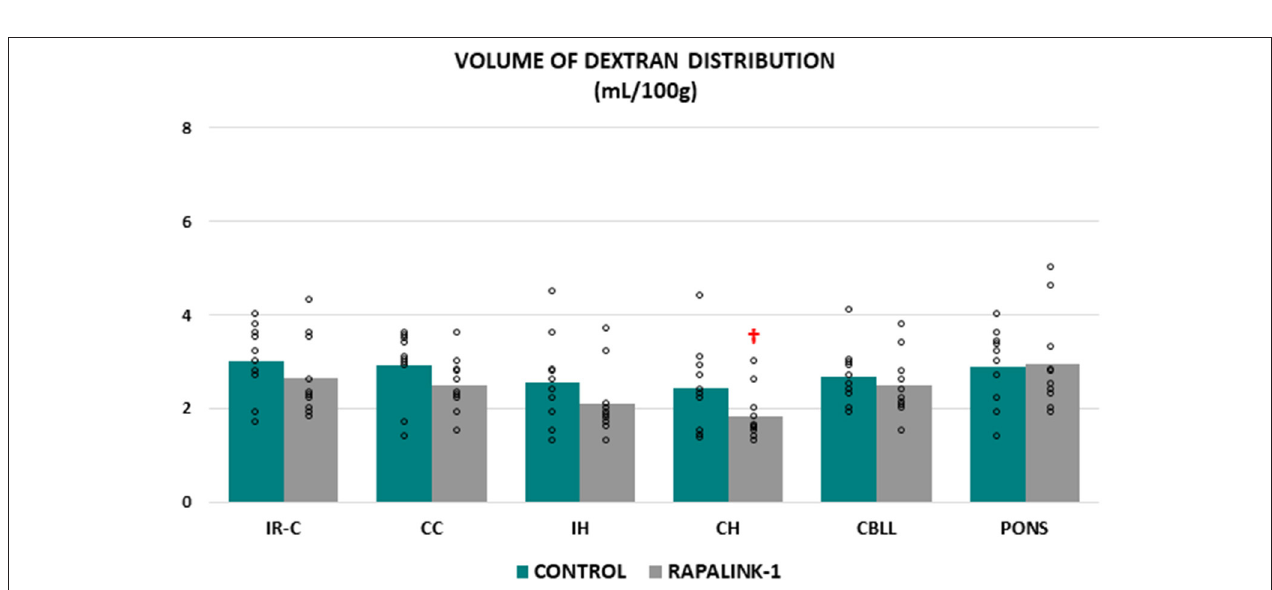
FIGURE 2 | Dot plots for the volume of dextran distribution in the examined brain regions of the control group (MCAO/reperfusion) and the Rapalink-1 group (MCAO/reperfusion + Rapalink-1) after 1h of MCAO and 2h of reperfusion. Each bar represents the mean value of each brain region. A two-way ANOVA followed by the Tukey’s test for multiple comparisons was used. There were no significant changes in the volume of dextran distribution with Rapalink-1 in every brain region that was studied. IR-C, ischemic-reperfused cortex; CC, contralateral cortex; IH, ipsilateral hippocampus; CH, contralateral hippocampus; CBLL, cerebellum. n = 10 in each group. † p < 0.05 vs.